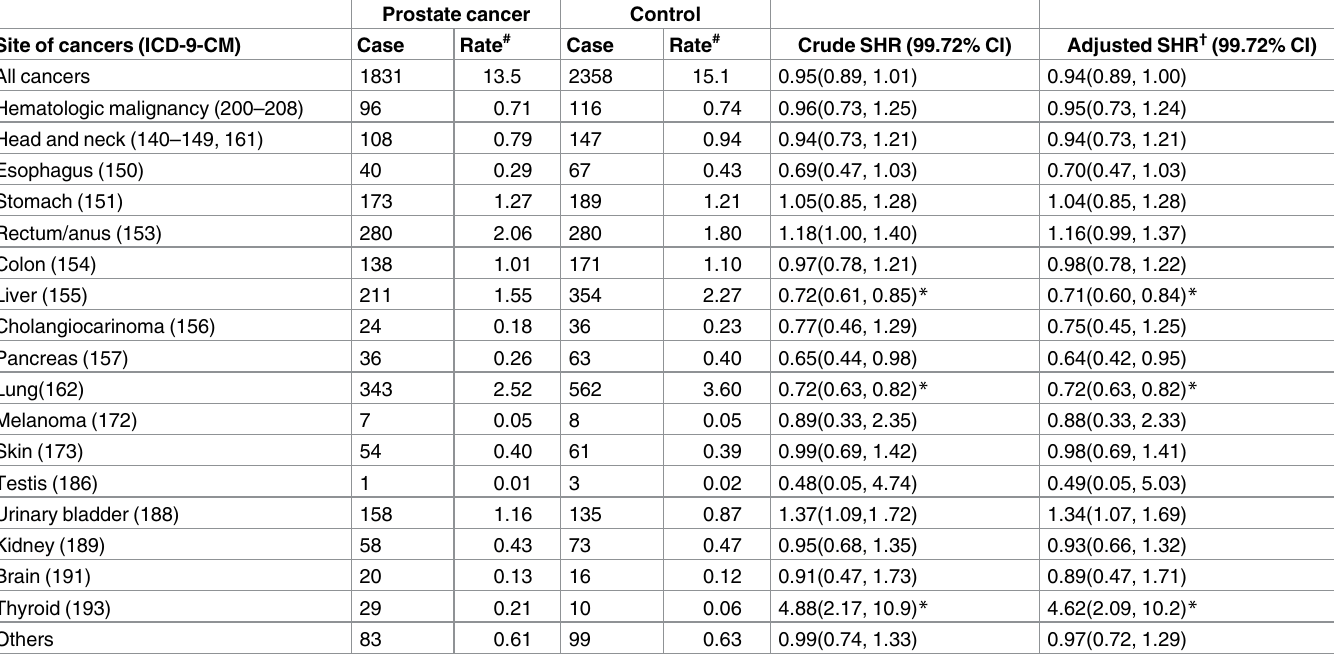
Table 2. Comparison of incidence and subhazard ratios of types of second primary malignancies according to prostate cancer status.